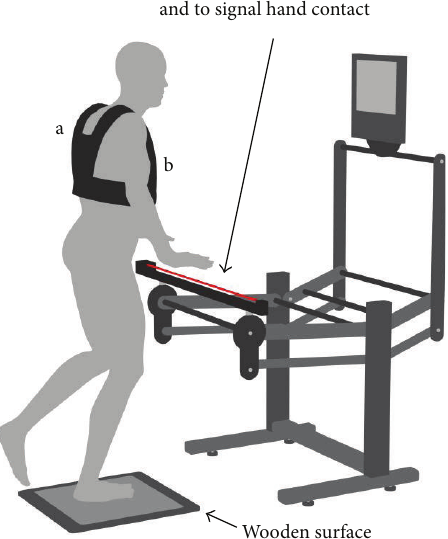
Figure 1: The postural proprioceptive station. The red line represents the infrared ray of the sensorized bar. Vest (a) to support the “postural reader”, (b) a two-dimensional accelerometer unit, in sternal